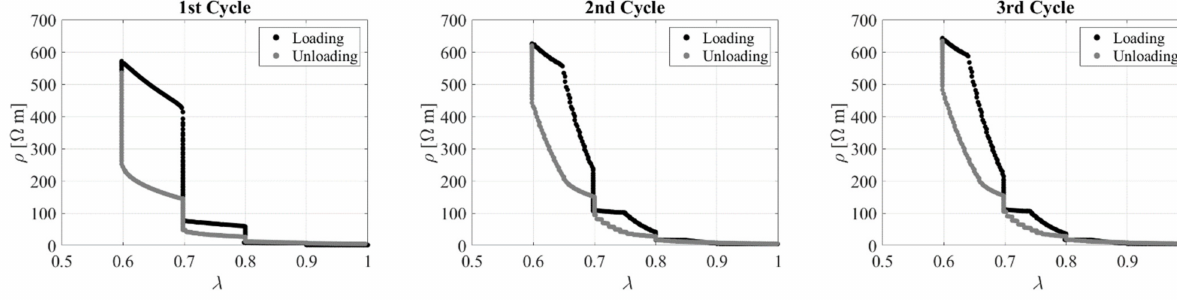
Figure 22. Resistivity vs. compression ratio during 3 cycles. Specimen with l 0 / d 0 = 0.1.